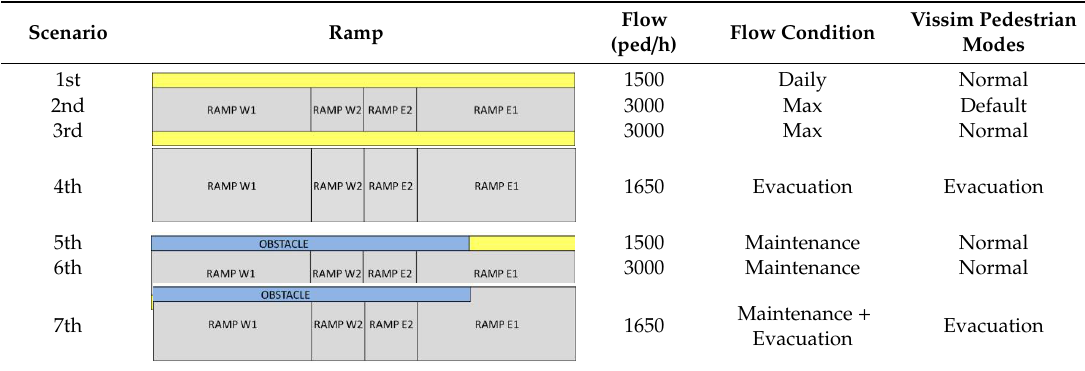
Table 5. Scenarios related to Stari Most bridge simulation.